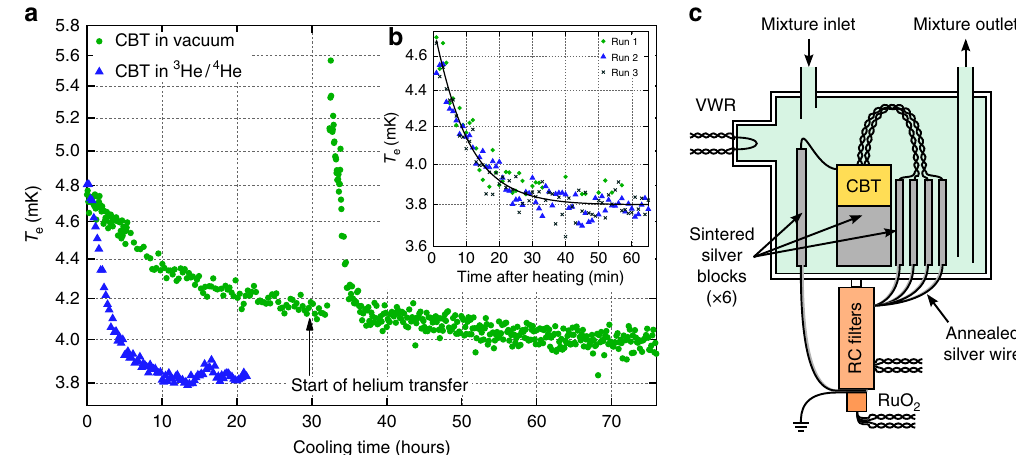
Figure 3 | Thermalization of two CBTs at a refrigerator temperature r 2.8mK. ( a ) Cooling of one CBT in vacuum (circles) and one immersed in the 3 He/ 4 He refrigerant of the dilution refrigerator (triangles). In both cases, the CBTs are cooling after being warmed above 10mK by temporarily increasing